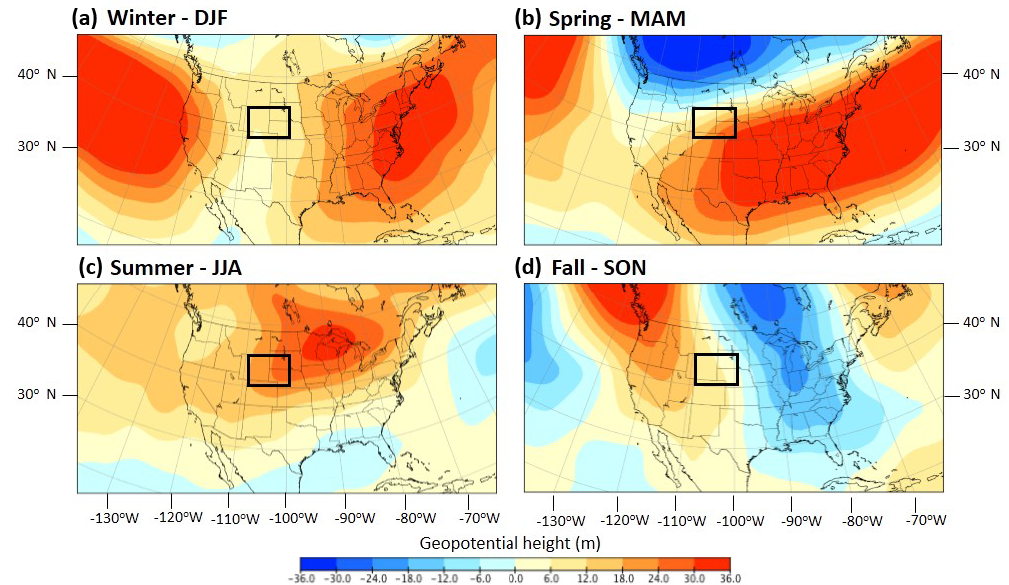
Figure 7. Composite-anomaly maps for 500mbar geopotential height during (a) winter (DJF); (b) spring (MAM); (c) summer (JJA); and (d) fall (SON). Positive values (warm colours) for 500mbar geopotential heights indicate a stronger-than-normal ridge. Negative values (cool colours) indicate a strong-than-normal trough. The black box denotes the study